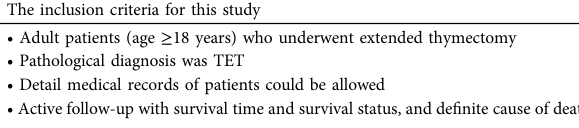
TABLE 1 Inclusion criteria.